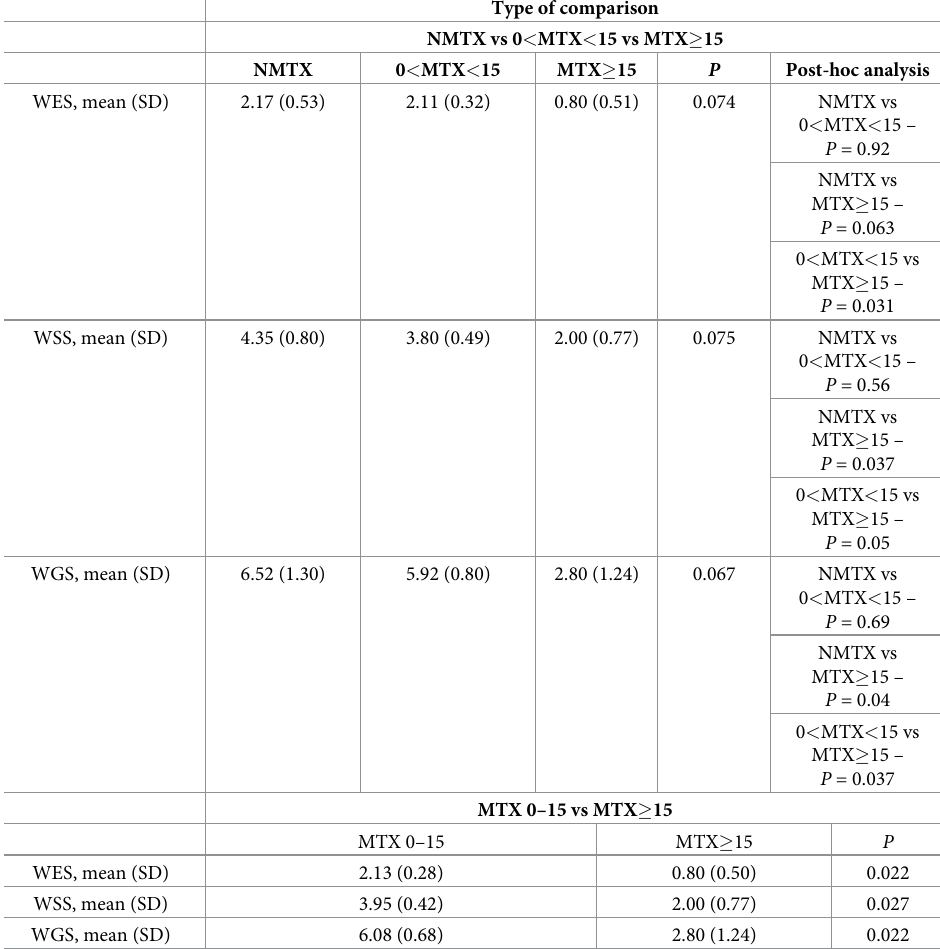
Table 4. Comparison of Warrick score depending on methotrexate